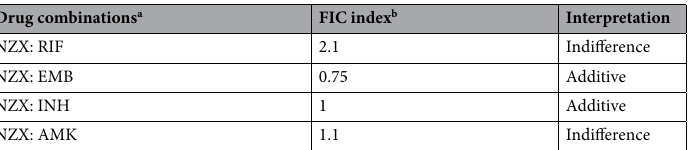
Table 1. FIC index of interactions between the peptide and first- and second-line anti-TB drugs. a NZX (peptide), RIF (rifampicin), INH (isoniazid), EMB (ethambutol), AMK (amikacin). b FIC Index borders: synergistic (≤ 0.5), additive (> 0.5–1), indifference (1–4), antagonistic (>